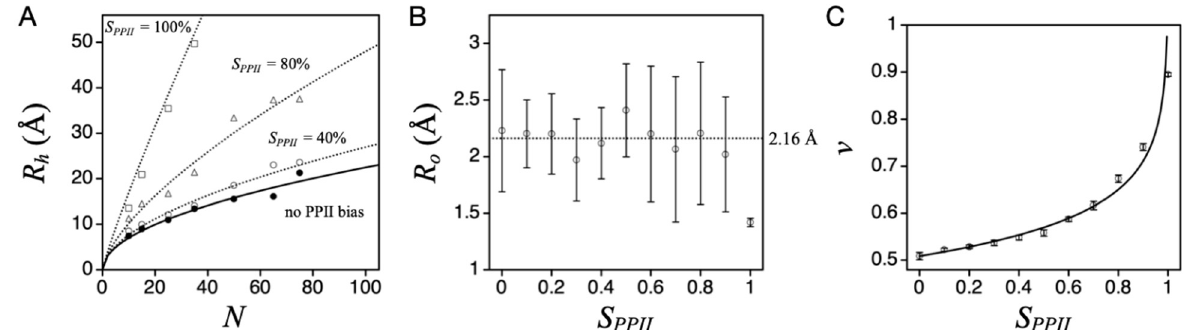
Figure 3. PPII bias expands the structural dimensions of the DSE. ( A ) The effect of an applied PPII sampling bias ( S PPII ) on mean R h (i.e., < L >/2) for poly-alanine at different N . Filled circles represent no preferential bias, while open circles, triangles, and squares show when S PPII is 40%, 80%, and 100%, respectively. ( B ) S PPII effects on fit parameter R o . Average R o for S PPII range of 0–90% is 2.16 Å, indicated by the stippled line. ( C ) S PPII effects on fit parameter v when R o is held constant at 2.16 Å. Line is from nonlinear least squares fit of these data to the logarithmic equation, v = v o + a ∙ ln (1 − S PPII ).